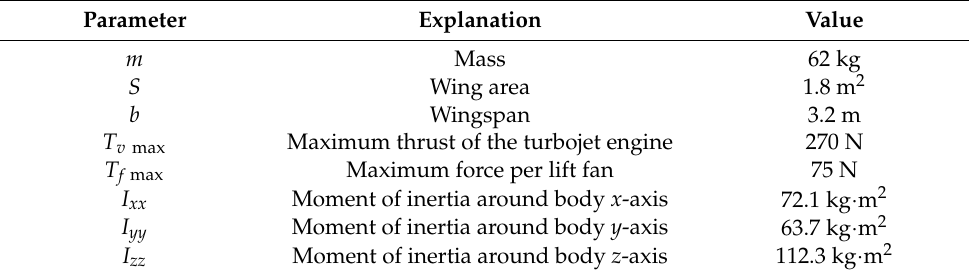
Figure 2. Top view of the flying-wing UAV. Table 1. Physical parameters of the target aircraft.